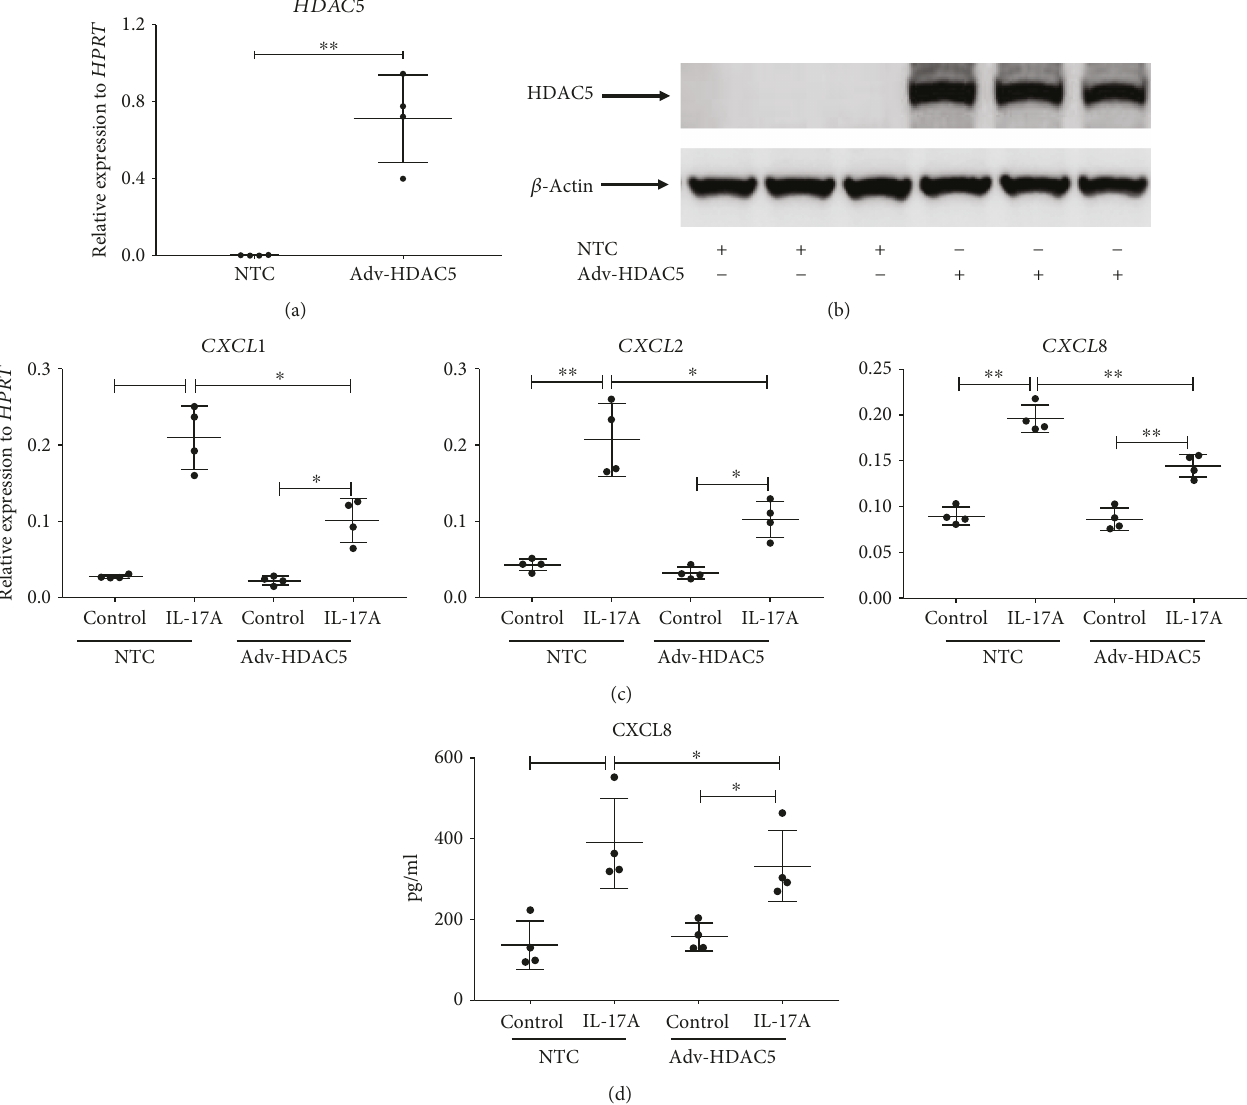
Figure 4: Induction of proin fl ammatory chemokines mediated by IL-17A can be suppressed by overexpressing HDAC5. HBE1 cells were plated 0.08-0.15 million cells per well in a 12-well plate. When 70-80% con fl uent, cells were transfected with 0.1 moi human HDAC5 adenovirus and nontarget adenovirus in 300 μ l medium, respectively, for one hour, and then we added 100ng/ml h-IL-17A protein or 700 μ l control medium directly into each corresponding well in both adenovirus-infected groups. 24 h after transfection, (a) HDAC5 , (c) CXCL1 , CXCL2 , and CXCL8 mRNA levels were determined by RT-PCR. (d) 48h supernatant after transfection was collected. CXCL8 protein level was achieved by ELISA. ∗ p < 0 05 ; ∗∗ p < 0 01 ; by paired t -test, two-tailed. (b) HDAC5 protein level of cells with adenovirus transfection for 24h was detected by Western blotting ( β -actin as reference). This experiment has been